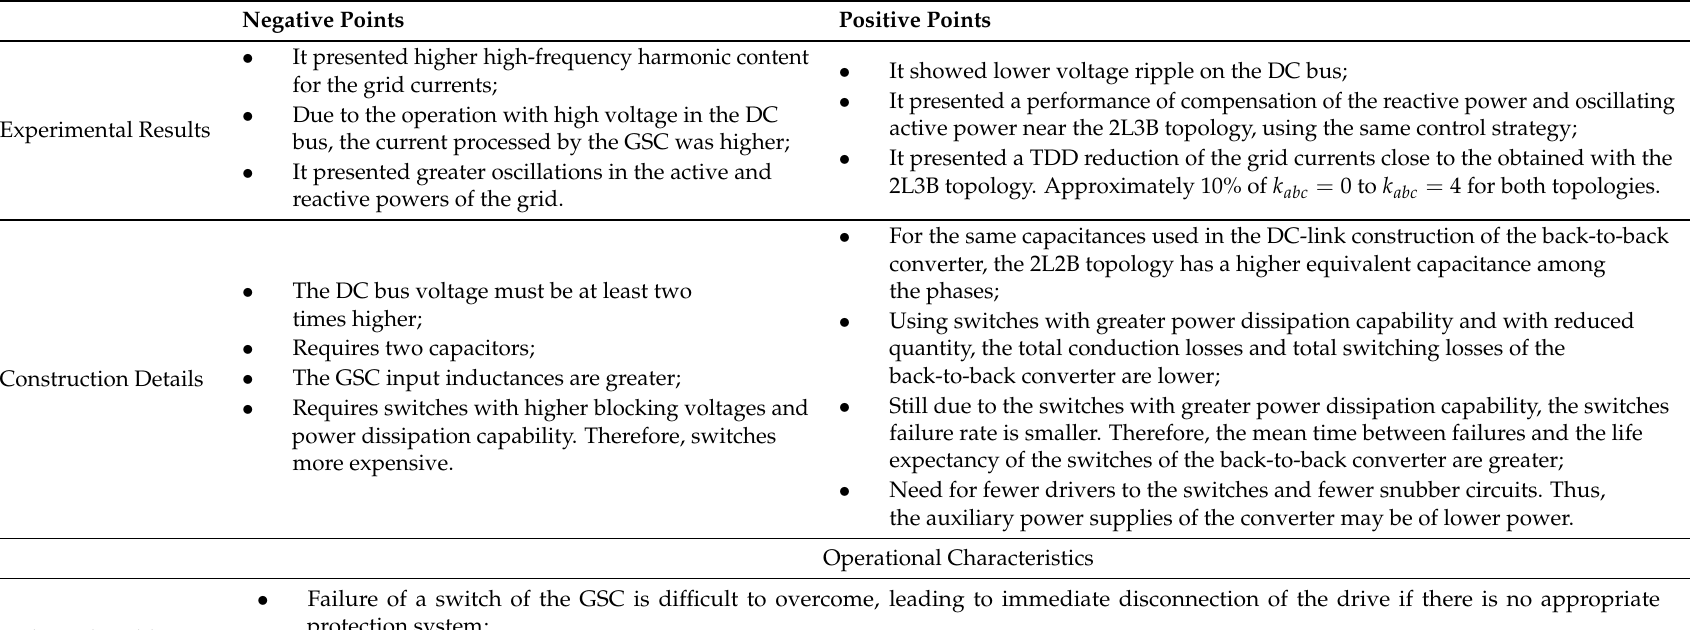
Table 5. Overview of the advantages and disadvantages of 2L2B topology as GSC in Type III WTG regarding 2L3B